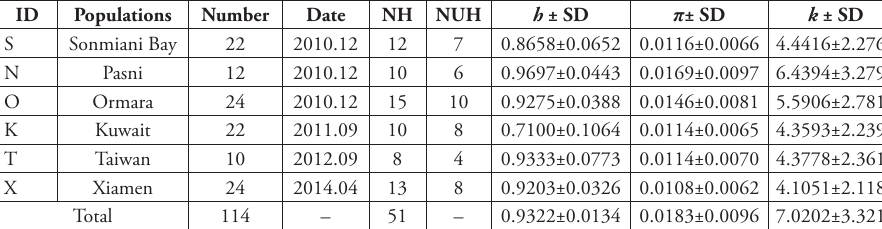
Table 1. Information and molecular indices of P. argenteus .